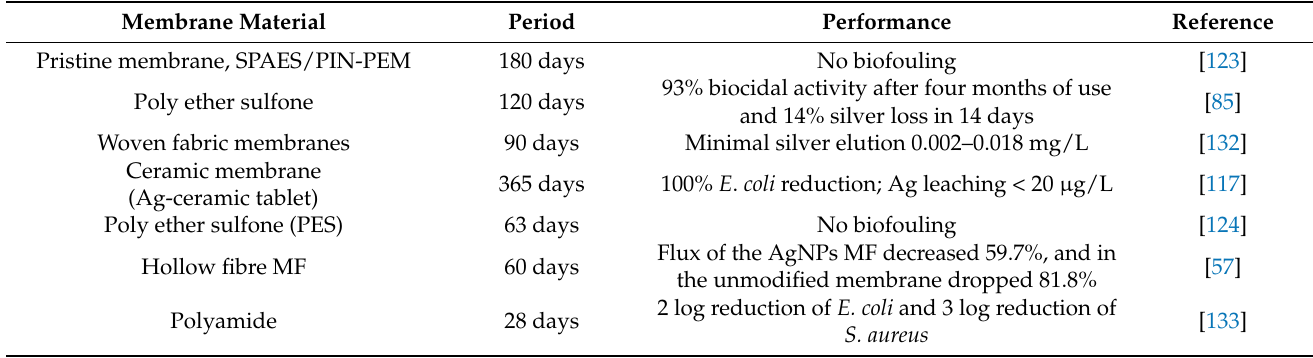
Table 5. Long-term performance of AgNP-coated